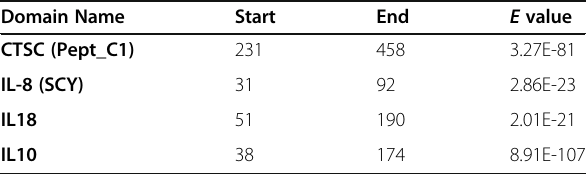
Table 3 Confidently predicted domains in CTSC, IL10, IL8,